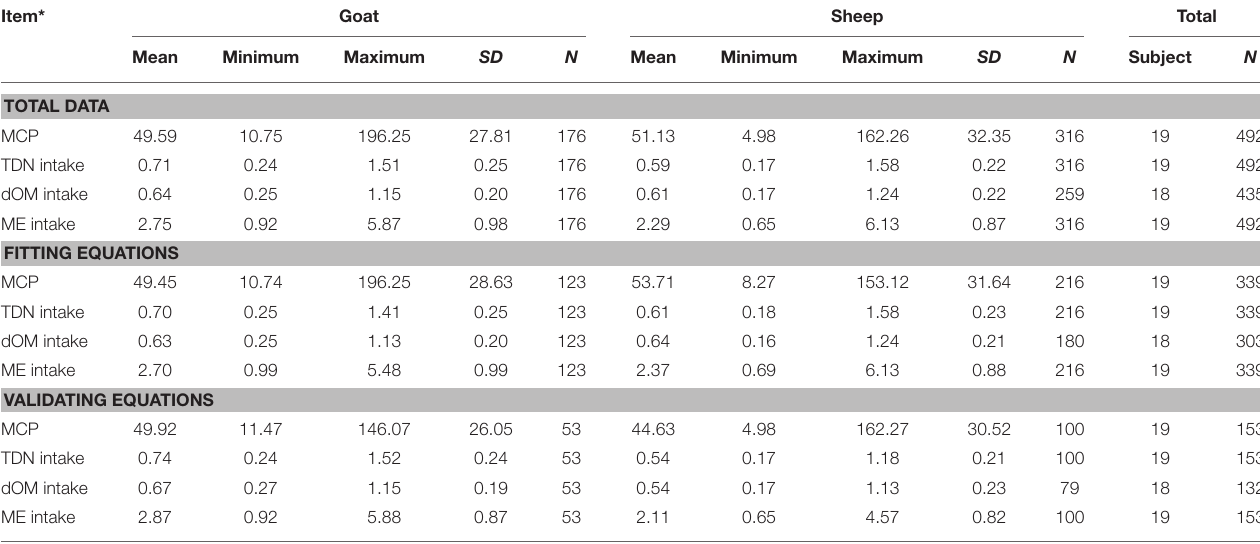
TABLE 1 | Descriptive statistics of the variables used to fit and validate models to estimate microbial crude protein efficiency in the rumen of goat and sheep species from energy intake measurements. Item* Goat Sheep